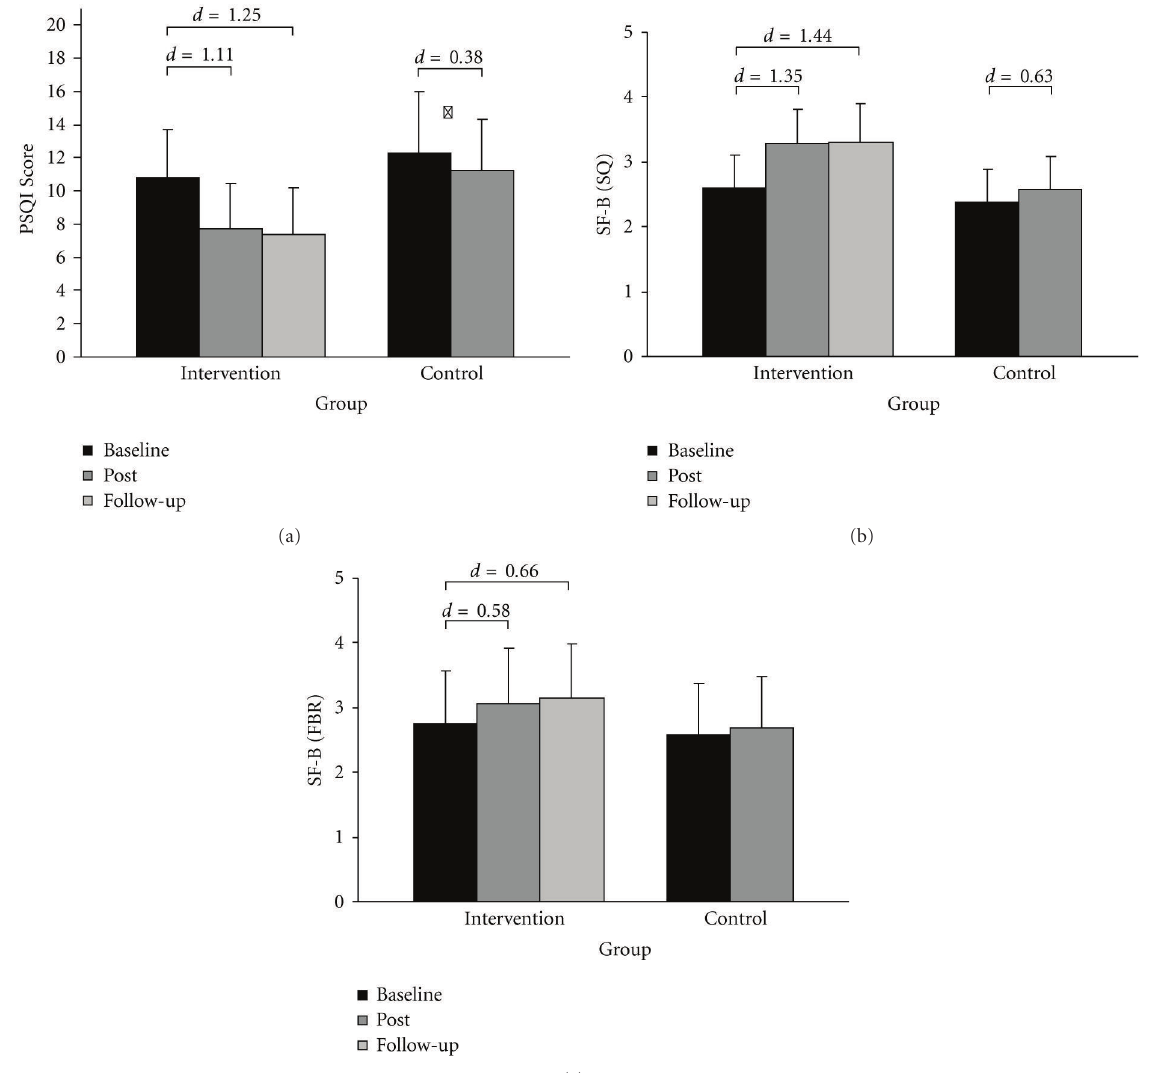
Figure 2: Mean and standard deviations for subjective sleep quality (SQ) and feeling of being refreshed in the morning (FBR) for the intervention and waiting-list control group. Lower rates indicate better sleep (PSQI). E ff ect sizes (Cohens d ) are demonstrated for significant t -tests P < . 001, ∗ P = .